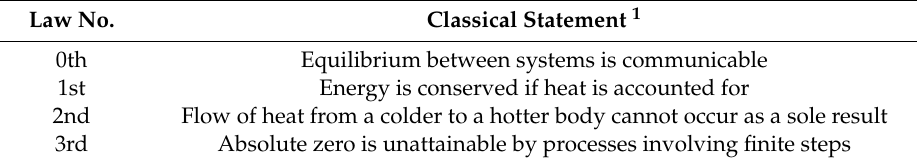
Table 2. Laws of